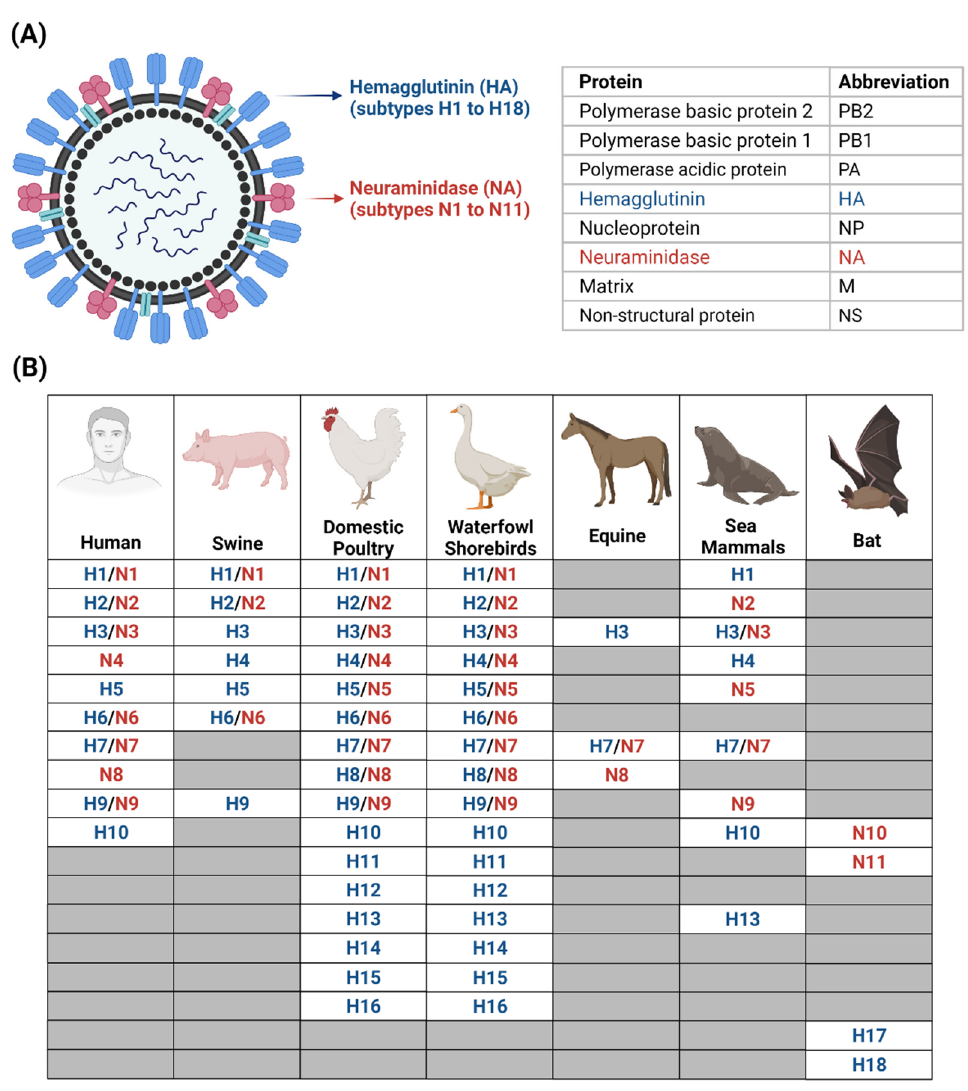
Figure 1. Influenza A viruses. ( A ) Structure of Influenza A viruses. ( B ) Hosts of Influenza A and their subtypes. Adapted from Mostafa et al. [6] and created with BioRender.com.